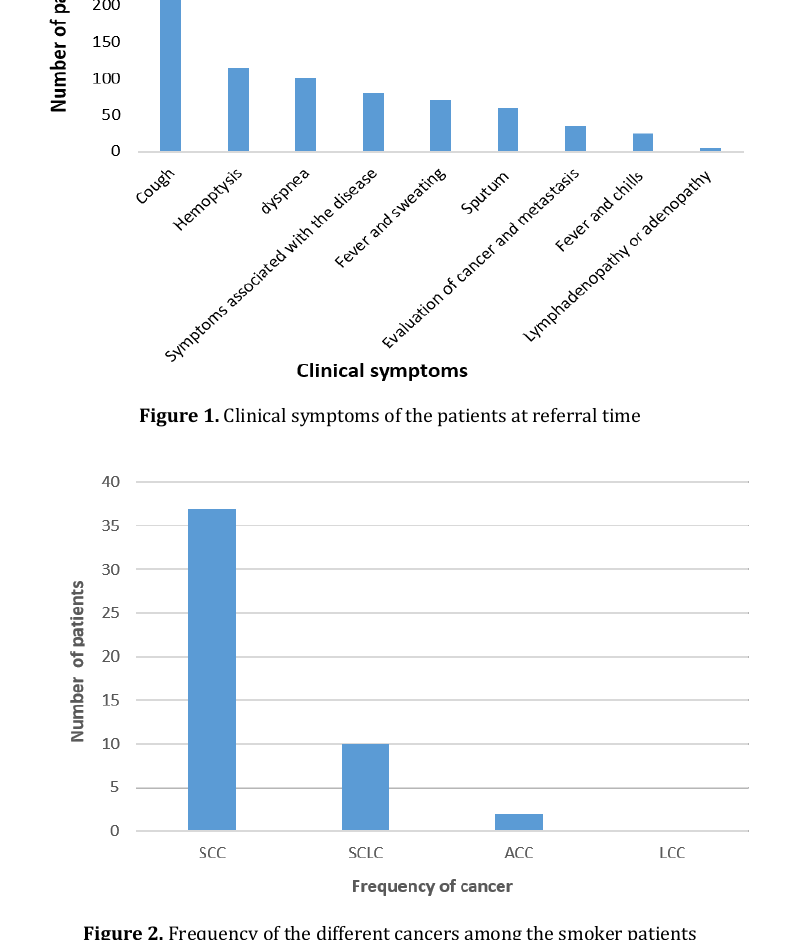
Figure 2. Frequency of the different cancers among the smoker